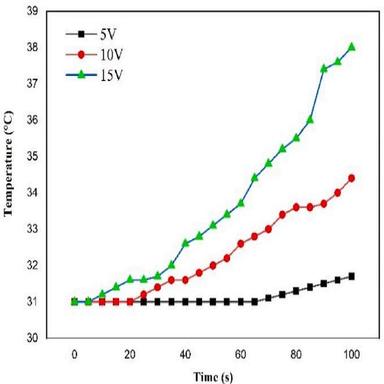
The time-dependent temperature profile of PANI-coated fabric at different potentials (5 V, 10 V, 15 V).